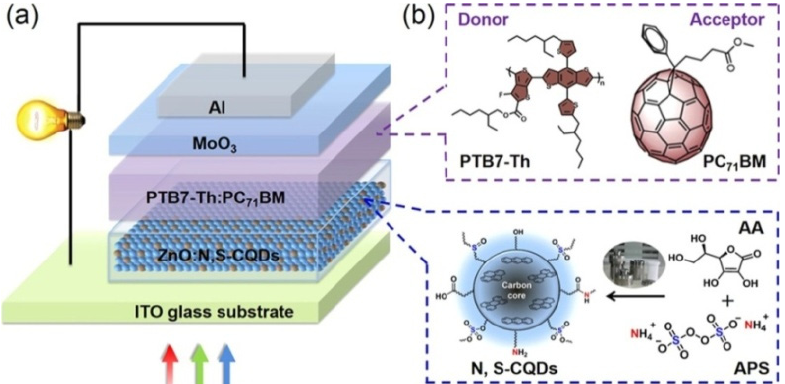
Figure 11. ( a ) Device configuration of inverted OSCs and ( b ) structural formula of active layer materials and sketch map of the synthesis of Nitrogen and Sulfur co-doped carbon quantum dots (N,S-CQDs). Reprinted with the permission of Reference [99]. Copyright 2019 American Chemical Society.